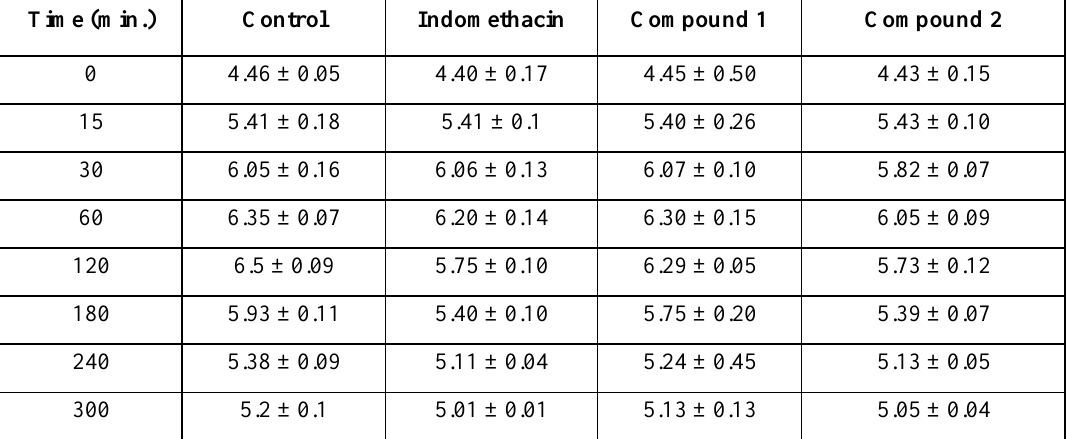
Table (1): The anti-inflammatory activity of the indomethacin and tested compounds. Time